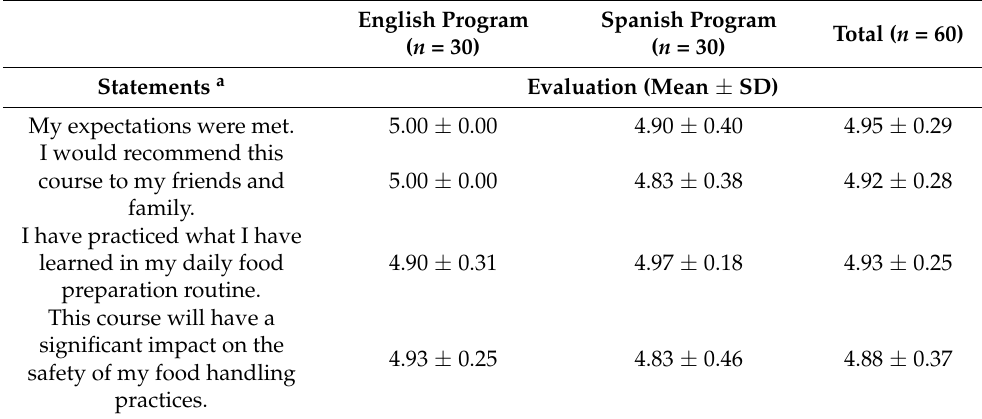
Table 5. Participant evaluation of the virtual food safety educational